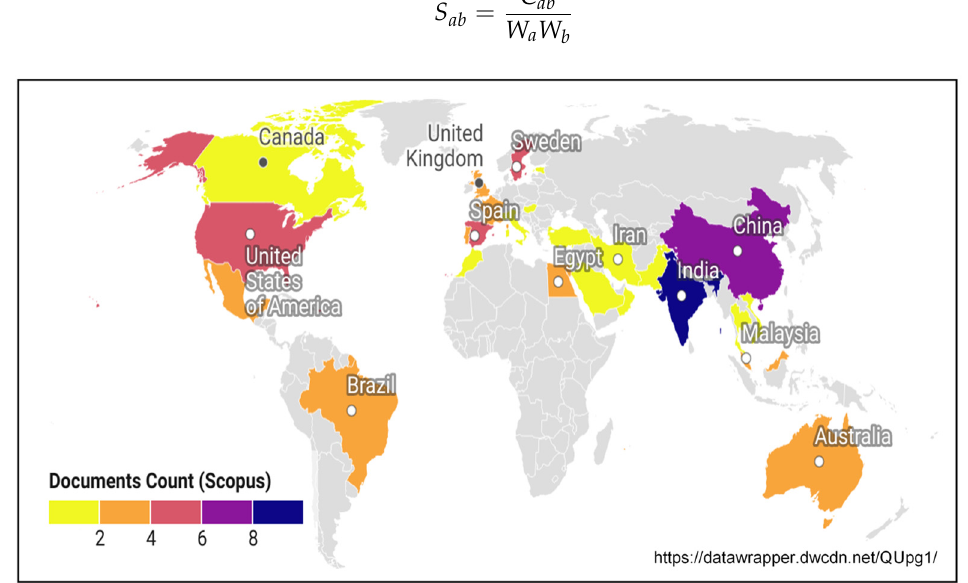
Figure 3. Globally distributed publications on research topic, bioremediation of pesticides by mi- croalgae from 2010–2020. croalgae from 2010–2020.